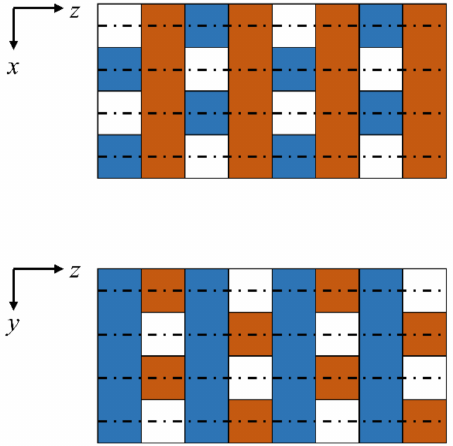
Figure 2. Side views of the layered porous structure in the x-z and y-z planes with dash-dot lines indicating planes of symmetry. Note that the planes of symmetry bisect the pores in lateral directions. In this figure, the parallelepipeds are alternately colored blue and red to indicate the same layers in the two